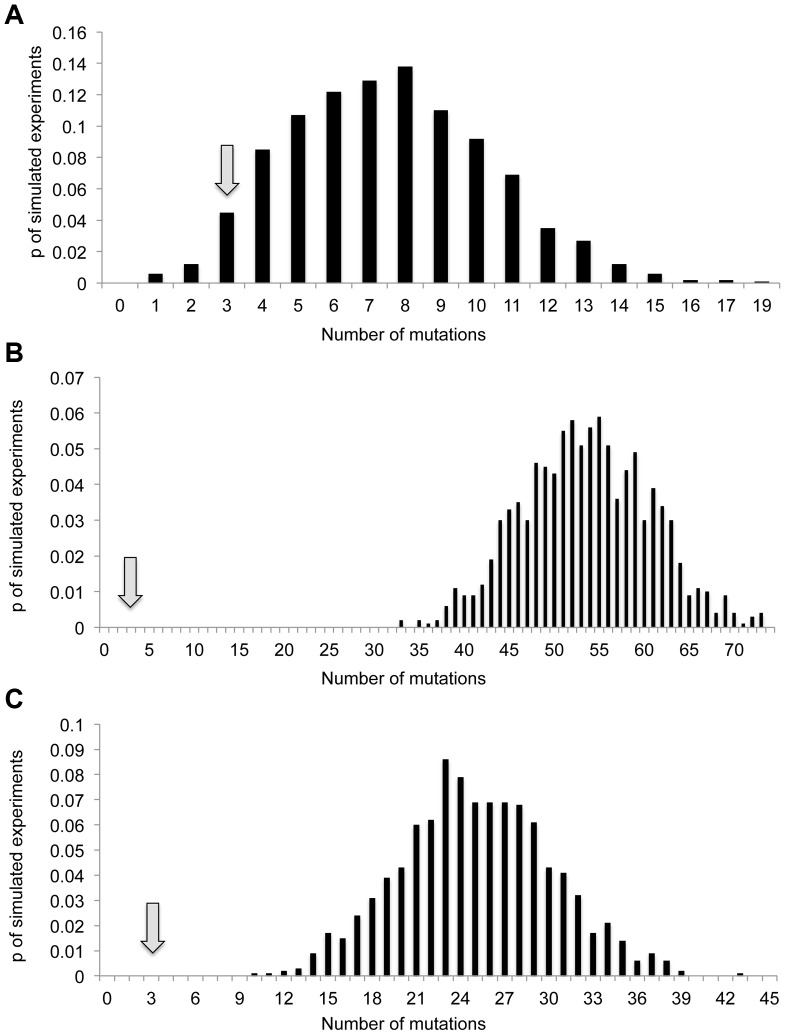
Actual number of observed mutations in 15 starved genomes is smaller than expected under a model of increased mutagenesis affecting the entire starved population.Drawn are the distributions of the numbers of mutations observed in simulations of 1000 experiments, in which 15 genomes are sequenced, under three different average mutation frequencies: (A) 0.5 mutations per genome (25–fold higher than expected under current estimates of mutation rates, assuming 20 generations). (B) 3.58 mutation per genome (179–fold higher than expected under current estimates of mutation rates, assuming 20 generations). (C) 25 mutations per 15 genomes (25-fold higher than the number of mutations we observed in the 15 non-starved genomes we sequenced. Arrows represent actual number of mutations observed in the 15 starved genomes we sequenced.